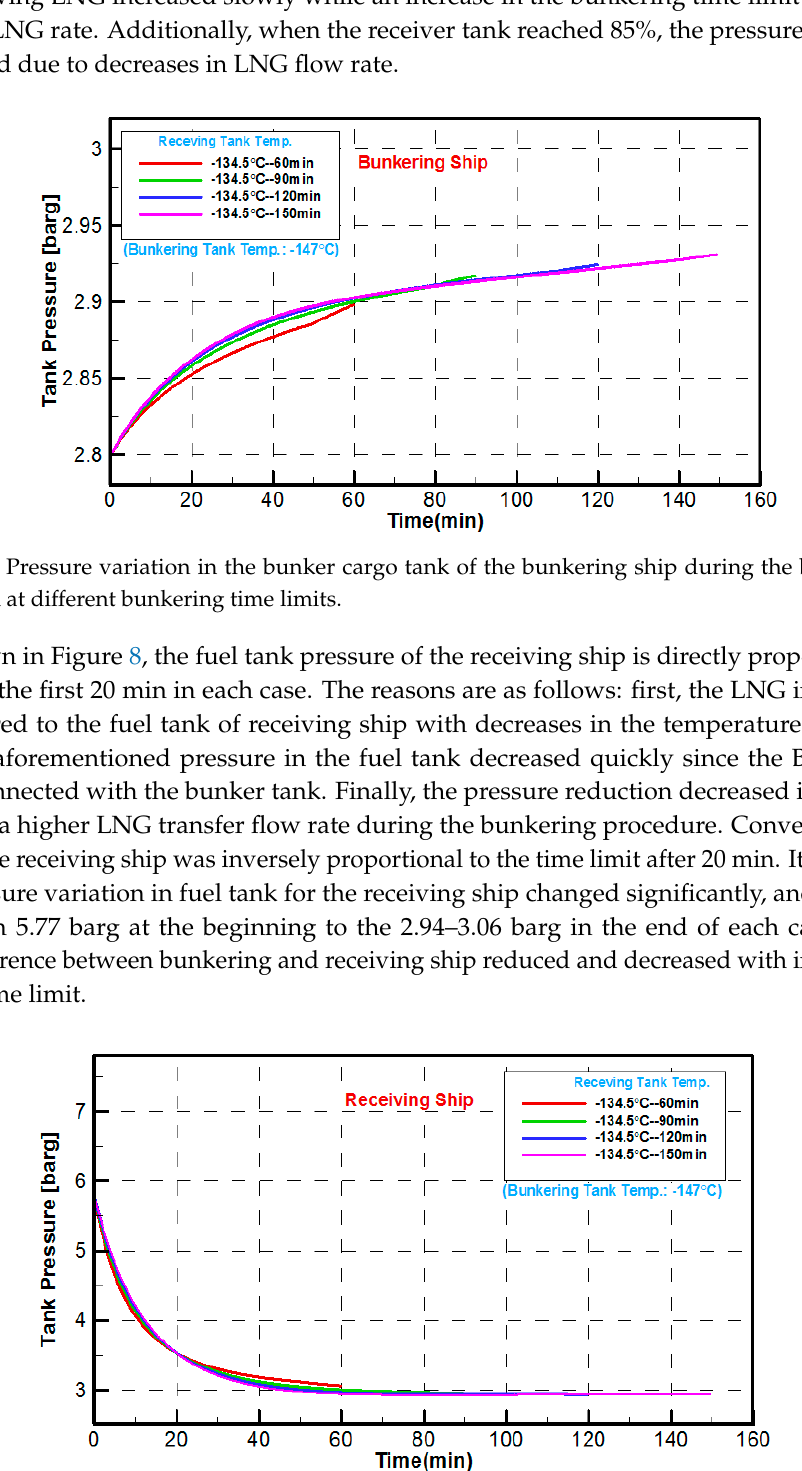
Figure 8. Pressure variation in the fuel tank of the receiving ship during the bunkering operation at different bunkering time